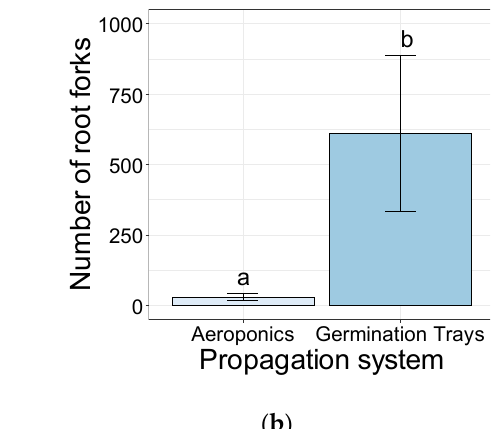
Figure 5. Number of roots tips ( a ) and number of root forks ( b ) of the softwood cuttings after 35 days of rooting, established in aeroponics systems and germination trays. Bars bearing the different letters are significantly different at p < 0.05.